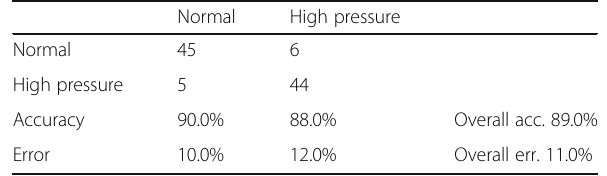
Table 6 Test confusion matrix for